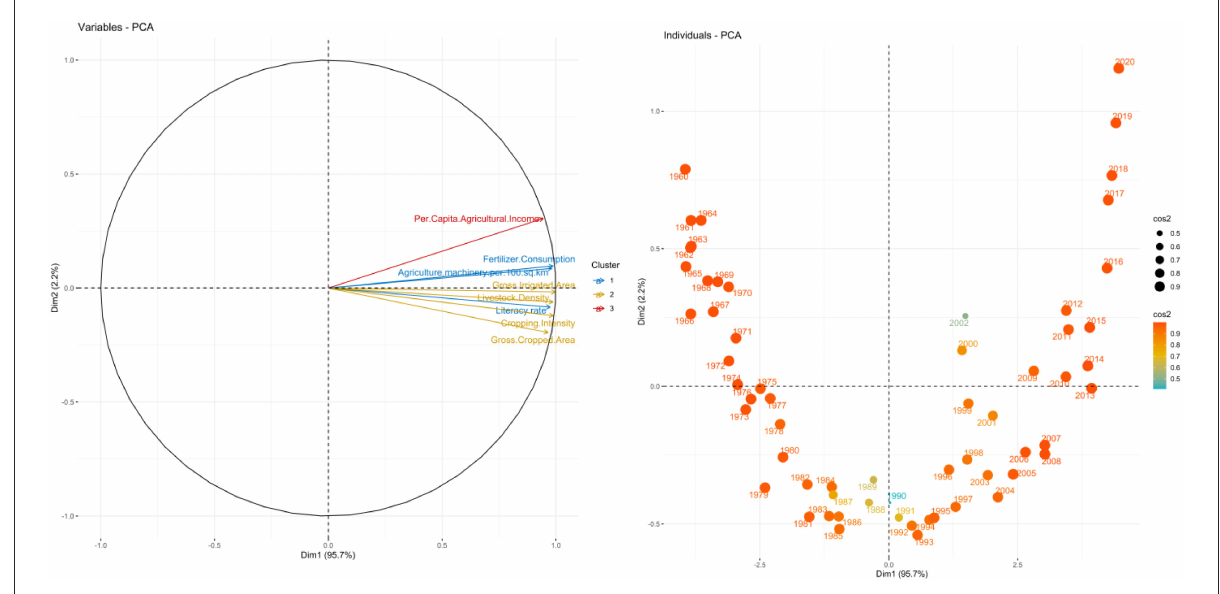
FIGURE4 Biplot between PC1 and PC2 and Principal Scatter plot of past six decades under Adaptive indicators.